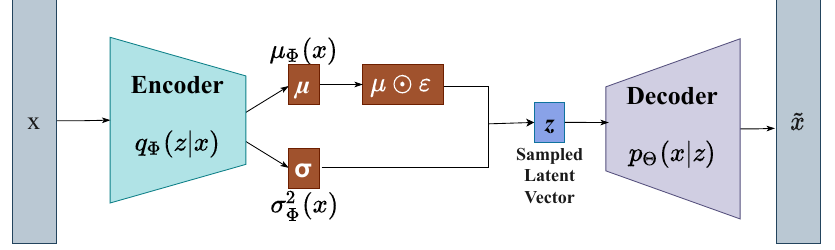
Figure 1. Basic architecture of a variational